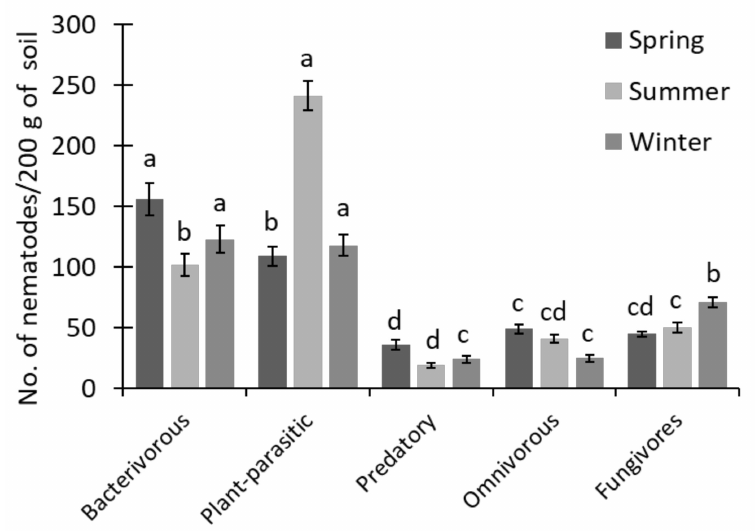
Figure 4. The trophic structure of the soil nematodes of the rice fields during the three different seasons of the year. Bars represent the mean of 72 soil samples ( ± SD) and different letters on the bars show the significance at p ≤ 0.05 among the different nematode groups at each season,